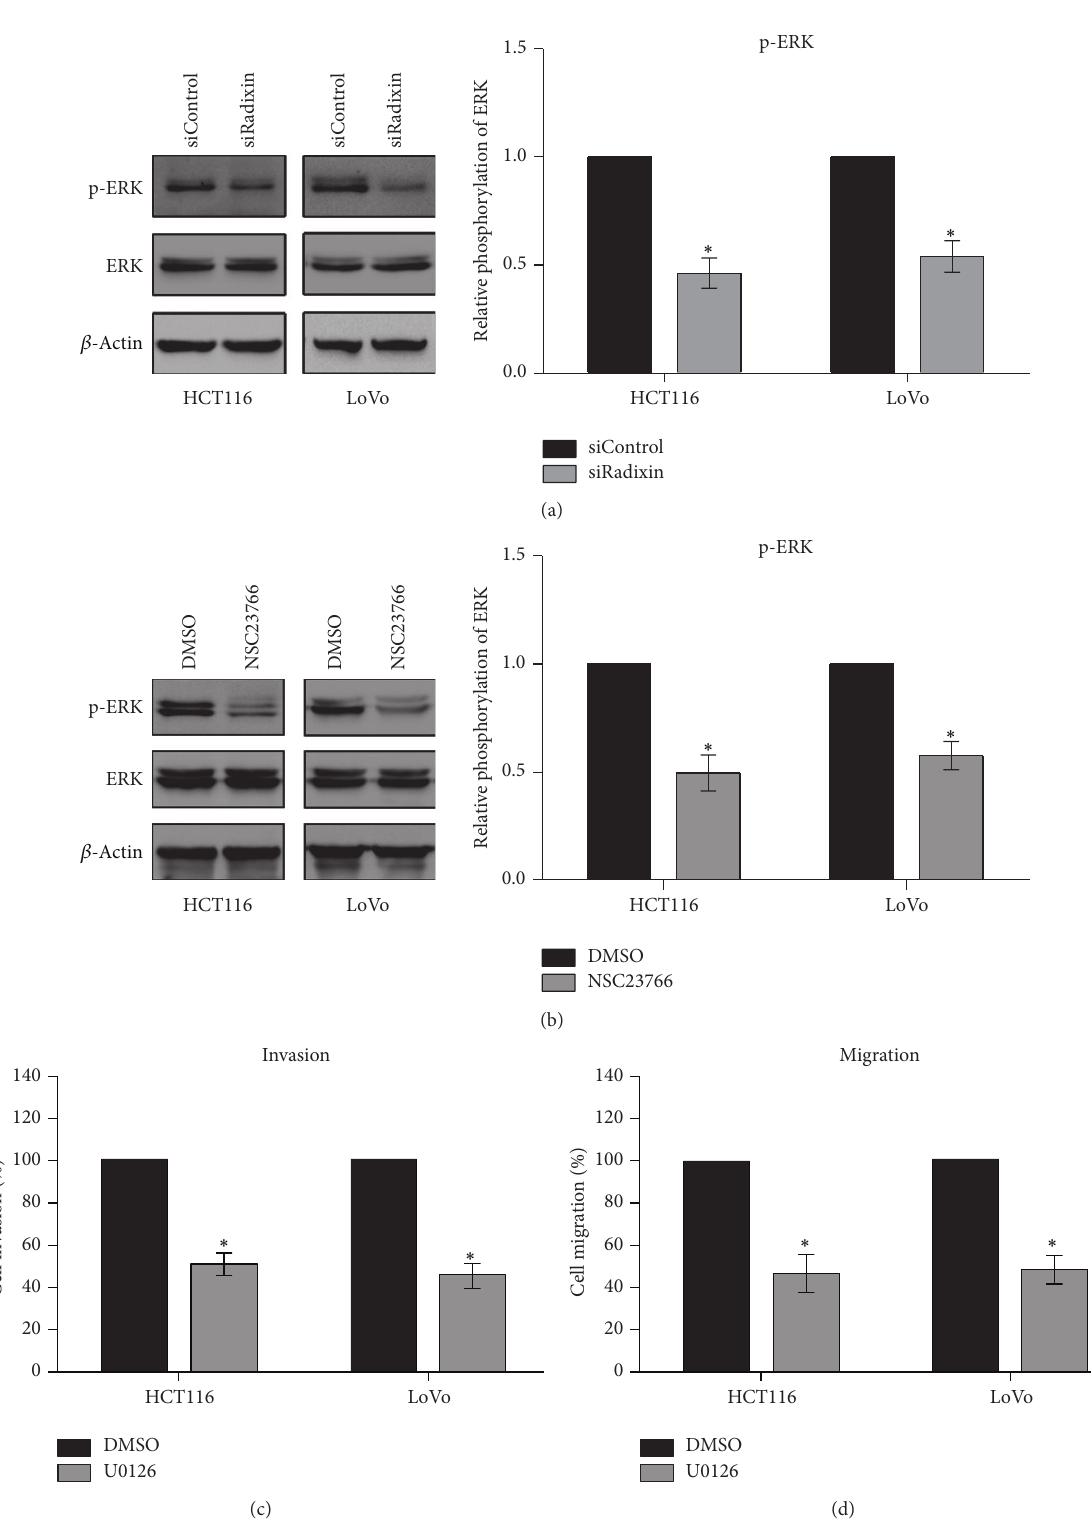
Figure 5: Rac1-ERK pathway was involved in the radixin-mediated invasion and migration of colon cancer cells. (a) After transfected with either control siRNA or radixin siRNA for 48h, the phosphorylation of ERK1/2 was detected by western blotting. (b) After incubation with NSC23766 or DMSO for 1h, the phosphorylation of ERK1/2 was detected by western blotting. (c) and (d) Cells were pretreated with U0126 or DMSO for 30 min and then were subjected to invasion and migration assays. ∗ 𝑃 < 0.05